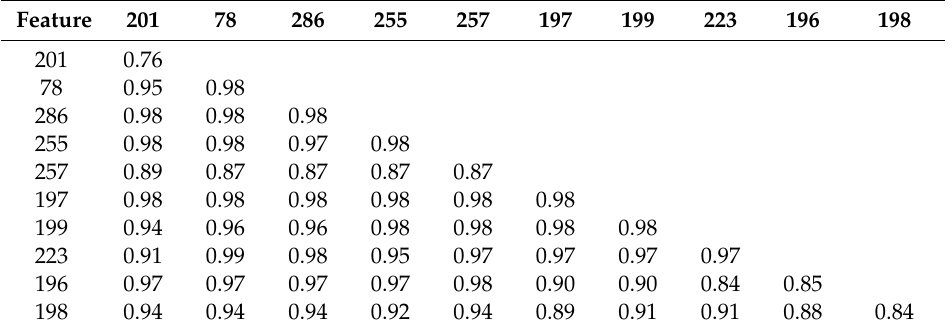
Table 8. E ff ect of selected features for level 1.